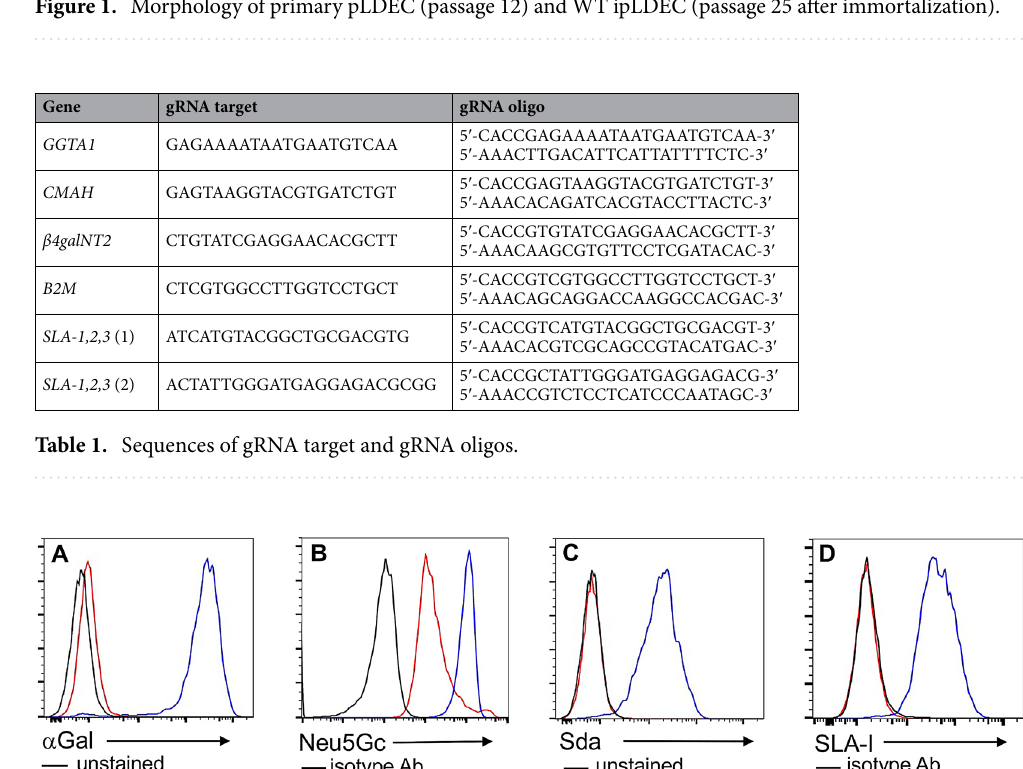
Figure 1. Morphology of primary pLDEC (passage 12) and WT ipLDEC (passage 25 after immortalization).